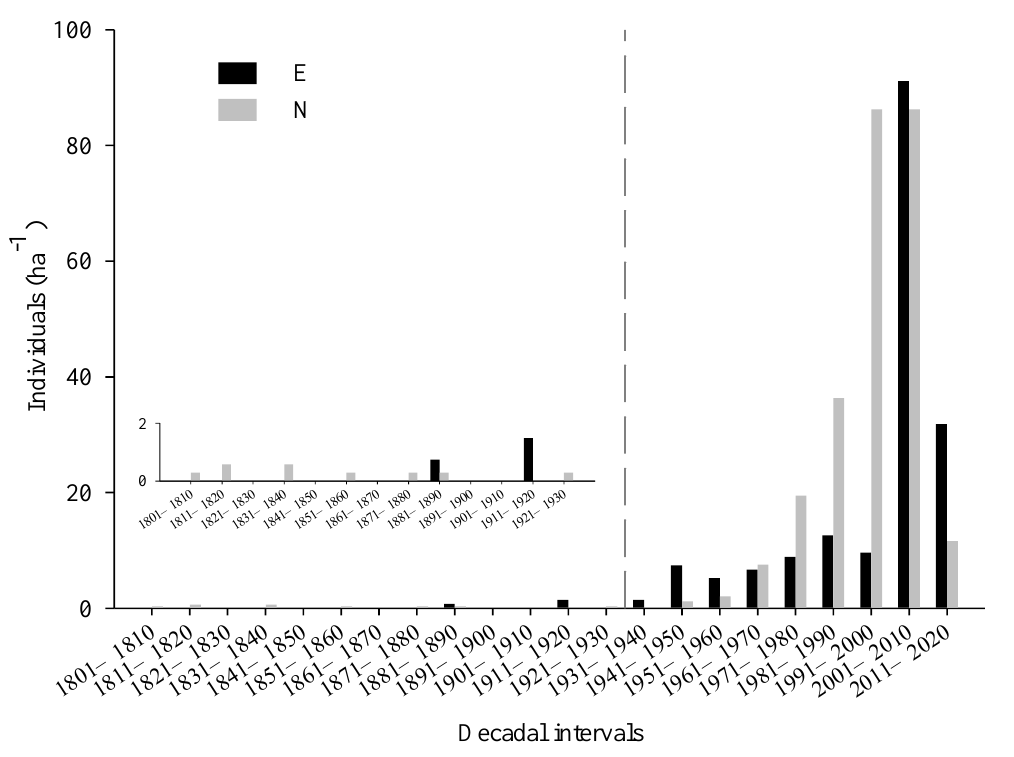
Figure 3. Age structures of Balfour spruce on the north- (gray bars) and east-facing slopes (dark bars). The inset shows the currently existing trees during 1801–1930.